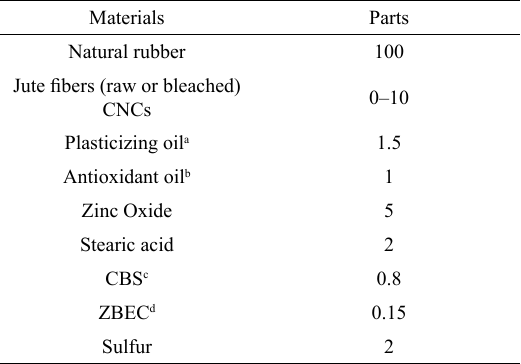
Table 1. Basic formulation of natural rubber